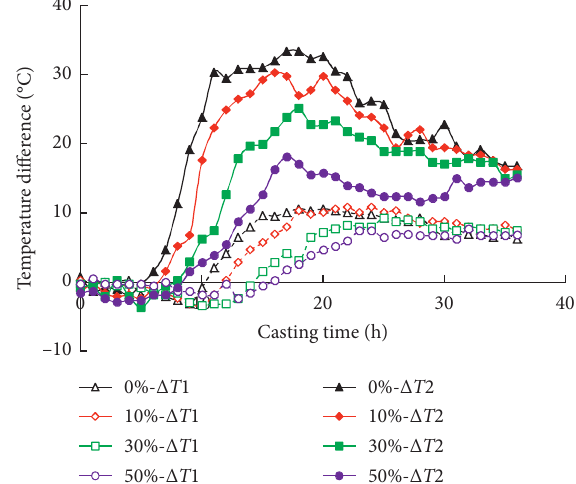
Figure 8: Relationship between temperature and casting time (containing fly ash). Note: 0%-1 denotes the value when the fly ash content is 0% in position 1.